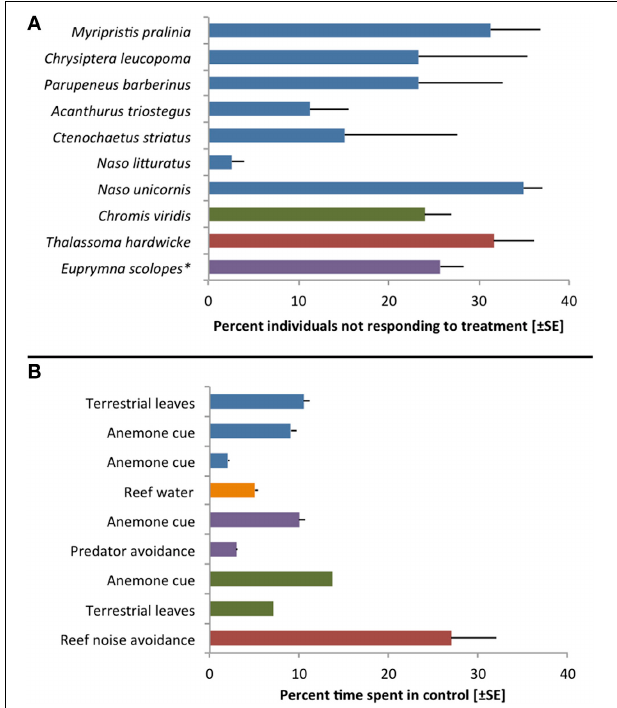
FIGURE 2 | Examples of inter-individual variation during choice trials with larvae of reef fishes and one invertebrate (*Cephalopoda). (A) Variation in settlement choices during laboratory trials. Bars indicate the percentage of specimens that showed no response or chose the control treatment in trials that revealed significant attraction to a specific settlement cue. Blue bars represent data from Lecchini et al. (2005a), purple: Lecchini et al. (2005b), red: Lecchini et al. (2007), green: Lecchini (2011). (B) Variation observed during choice flume trials with larvae of the anemonefish Amphiprion percula . All but the last bars represent the percentage of time ( ± SE; not available for Dixson et al., 2014) that larvae spent on the control side of a 2-channel choice flume. The last bar indicates percent time spent on the side of a choice chamber that emitted reef sound (including predator sounds) usually avoided by larvae. While one cannot determine individual variability from this overall average, there is clearly unexplained variation in all experiments. Blue bars represent data from Dixson et al. (2008), orange: Dixson et al. (2011), purple: Dixson (2012), green: Dixson et al. (2014), red: Simpson et al. (2011).